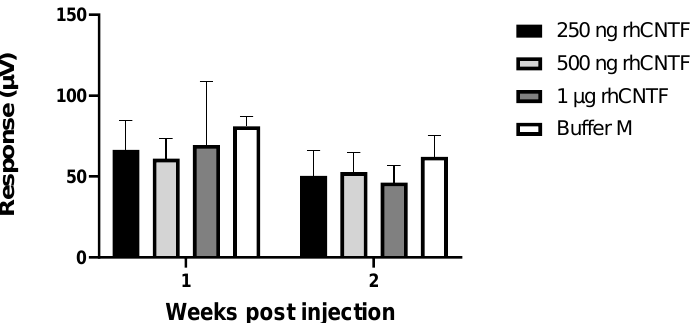
significant difference in the responses between any of the treatment groups could be detected.